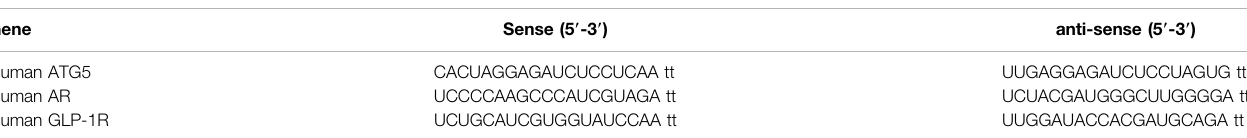
TABLE 3 | Speci fi c sequences for